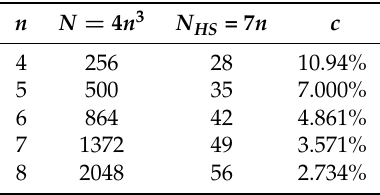
Figure 1. The structures of studied crystals with nanochannels in the [ 111 ] -crystallographic direction: ( a ) with green are marked particles which interact via the hard-core repulsive Yukawa pair potential (HCRYP), while red particles represent the hard spheres; ( b ) to better illustrate the structure of nanochannel, the centers of Yukawa particles are marked by green dots; and ( c ) periodic boundary conditions result in the structure with periodic array of nanochannels. Table 1. Summary of the parameters of the studied systems: n , number of fcc cells on the edge of the system; N , total number of particles in the system; N HS , number of hard spheres forming the inclusions; c , concentration of nanochannel